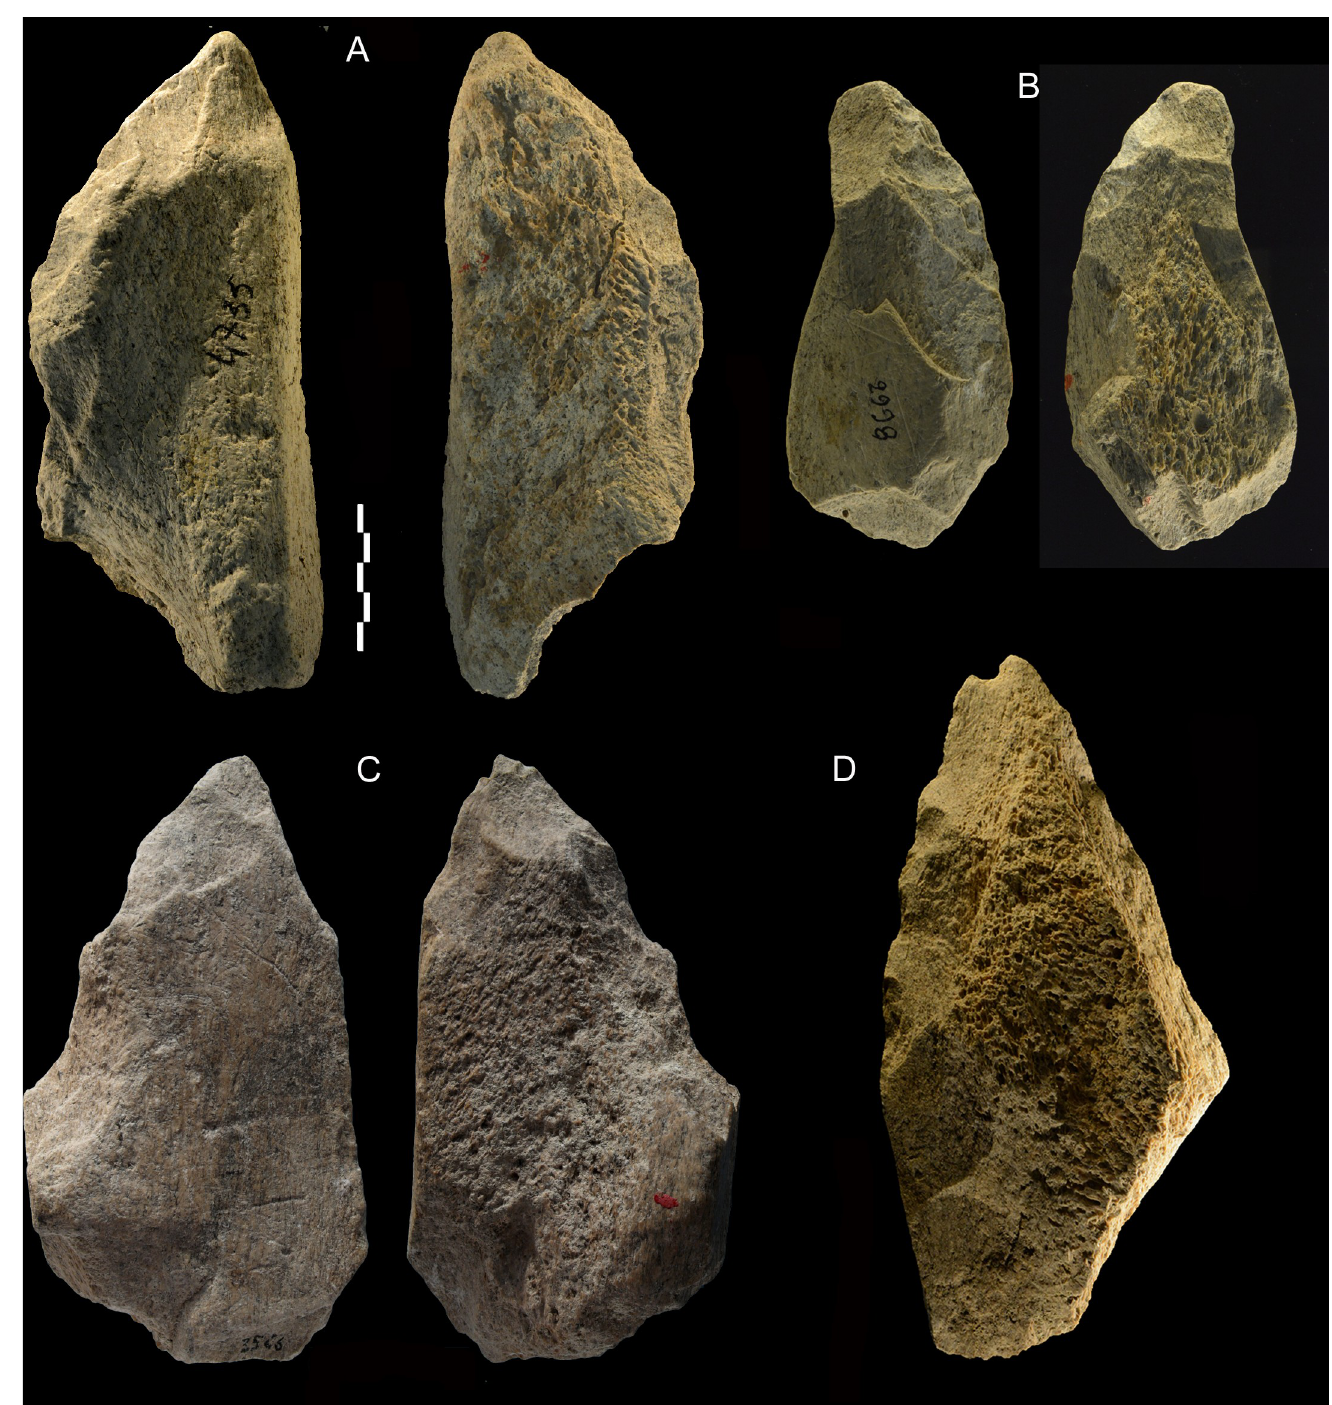
Fig 9. Castel di Guido. Partial bifaces-knives. (A-C) are asymmetrical large tools bifacially flaked on one side with a steep opposite side, either natural (as on these pieces) or blunted by retouch. This type of tools is found in the Middle Pleistocene Acheulian stone tools of East Africa where they are called “knives” [35, 36]. To our knowledge, these forms were not previously documented in the European Acheulian. (D) is unifacially flaked with a natural steep back. Catalogue numbers 4735, 2998, 3566, x281. Scale bar 5 cm.